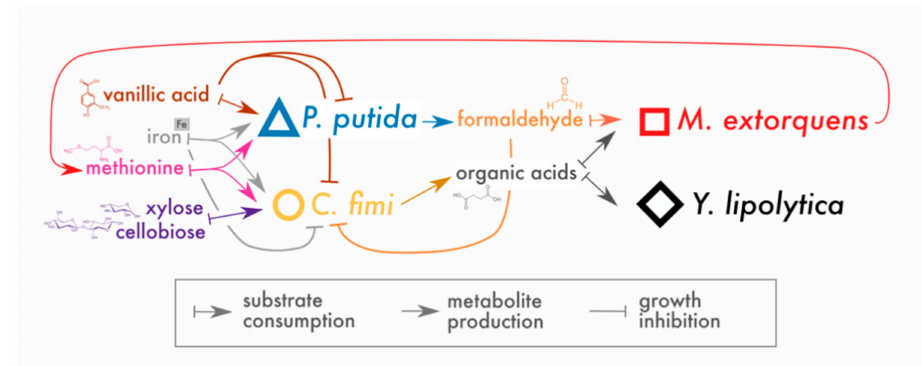
Figure 10. Revised conceptual model of interactions in model lignocellulose-degrading microbial consortium. To our original model, we have added competition between P. putida and C. fimi for iron and methionine, and inhibitory effects of vanillic acid on C. fimi and P. putida and high concentrations of iron on C. fimi . We have found little evidence for inhibitory effects of formaldehyde (at the concentrations produced here) on any of the members besides C. fimi ; there is evidence that C. fimi , but not P. putida , supports M. extorquens growth, likely through organic acid production. In addition, we have added the ability for M. extorquens to support C. fimi through the production of